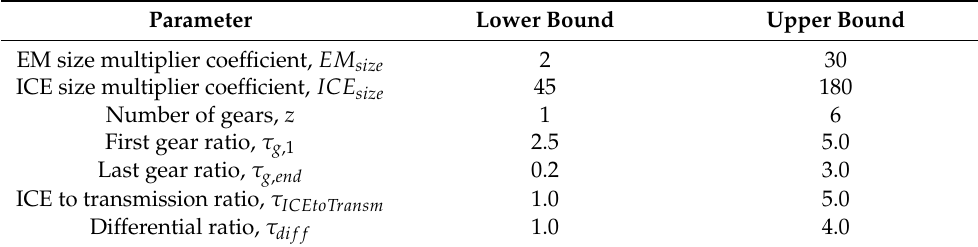
Table 2. Particle swarm optimization (PSO) design parameters and their ranges.